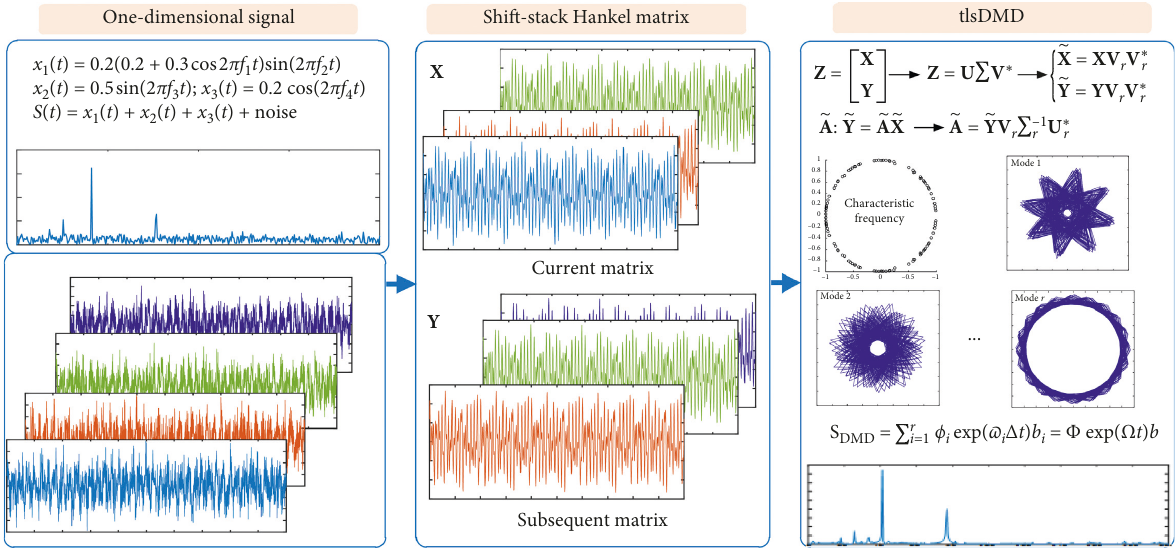
Figure 1: tlsDMD implementation process for one-dimensional simulation signal.